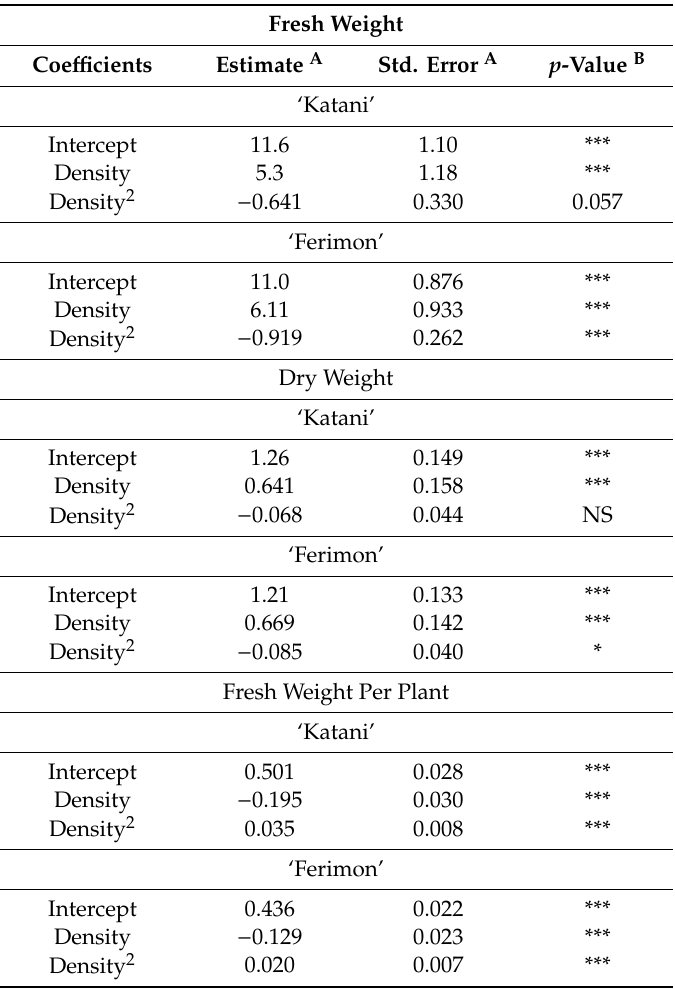
Table 6. Regression values for growth parameters by sowing density for ‘Katani’ and ‘Ferimon’, including squared terms for a quadratic